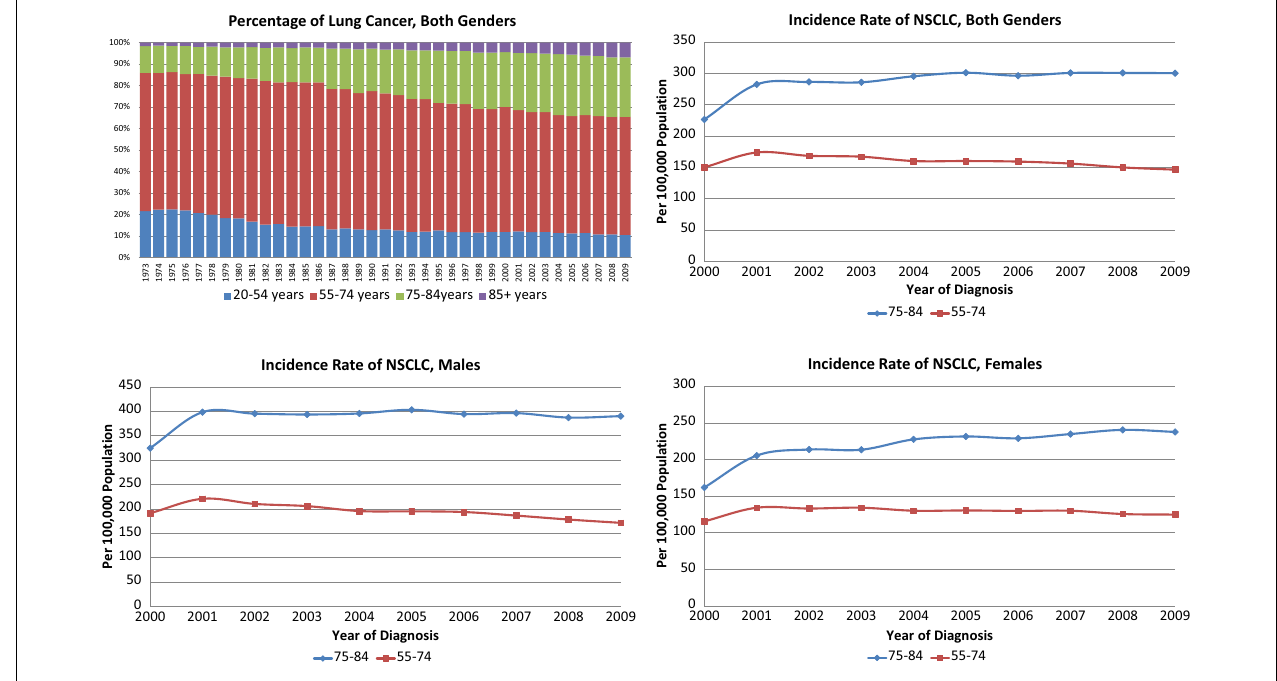
FIGURE 1 | Incidence and proportions of non-small cell lung cancer, 2000–2009 in both genders, females and males .